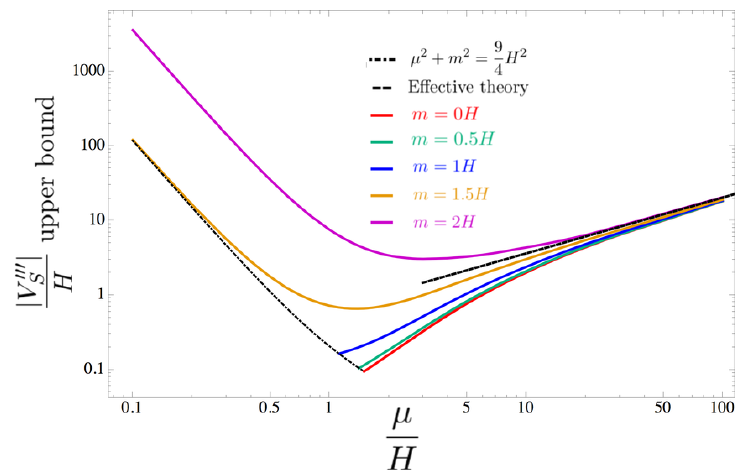
Figure 9 . Upper bounds on j V 000 j as a function of (cid:22)=H . These bounds are imposed by experimental S bounds on f equil . Bounds are plotted for m = 0, 0 : 5 H , H , 1 : 5 H , and 2 H . There is also a bound NL computed from the large (cid:22)=H e(cid:11)ective theory, shown in the (cid:12)gure as a black dashed